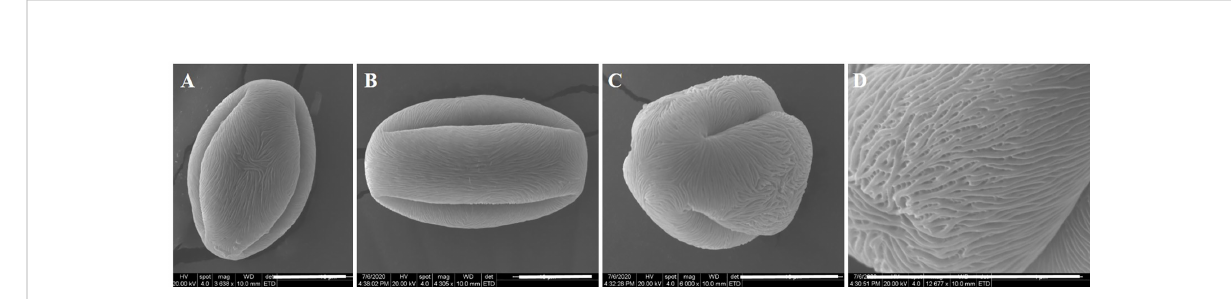
FIGURE 1 Ultra-morphology of pollen grains of E. racemosa under the SEM. (A, B) Equatorial view; (C) Polar view; (D) Exine sculptures. Bar = 10 m m.